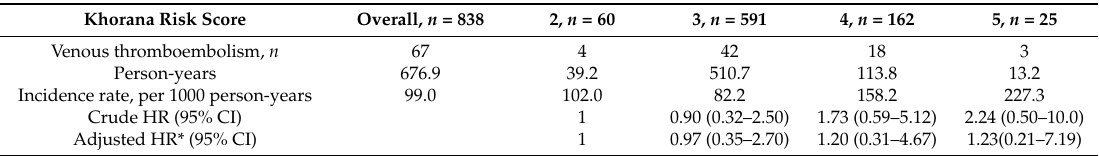
Table 4. Venous thromboembolism incidence rate and hazard ratios (HR) among patients with pancreatic cancer, stratified by Khorana risk score.